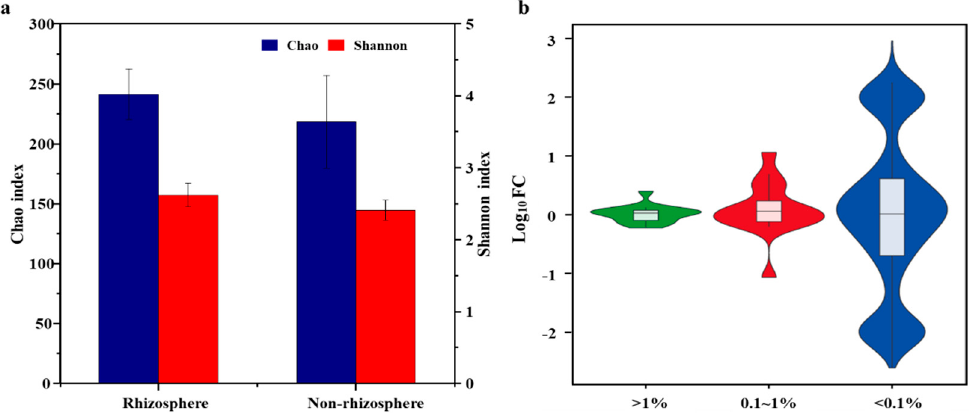
Figure 1. Chao and Shannon indices of the fungal communities in the soils ( a ). The effect of different soil environments (rhizosphere and non-rhizosphere) on the fungal community shift is shown by violin plots ( b ). The relative abundance of the operational taxonomic units (OTUs) are categorized as high-abundance ( > 1%), medium-abundance (0.1~1%) or low-abundance ( < 0.1%). FC = the abundance of OTUs in rhizosphere soils/the abundance of OTUs in non-rhizosphere soils.